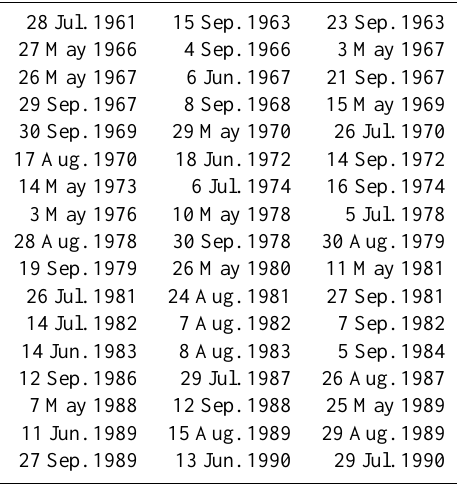
Table 1. Dates of 51 moderate to strong winter geomagnetic storms in the period 1961–1990, as identified from D st